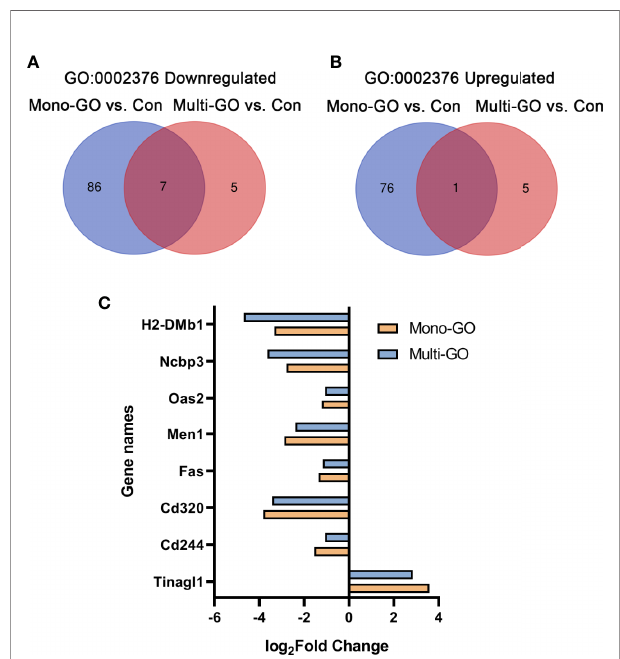
FIGURE 6 | Venn diagram of upregulated and downregulated immune system process (GO: 0002376) after exposure to mono – graphene oxide (GO) and multi- GO compared with control. (A) Venn diagram of downregulated immune system process (GO: 0002376). (B) Venn diagram of upregulated immune system process (GO: 0002376) (C) The fold change in differentially expressed genes shared between mono-GO vs. control and multi-GO vs.